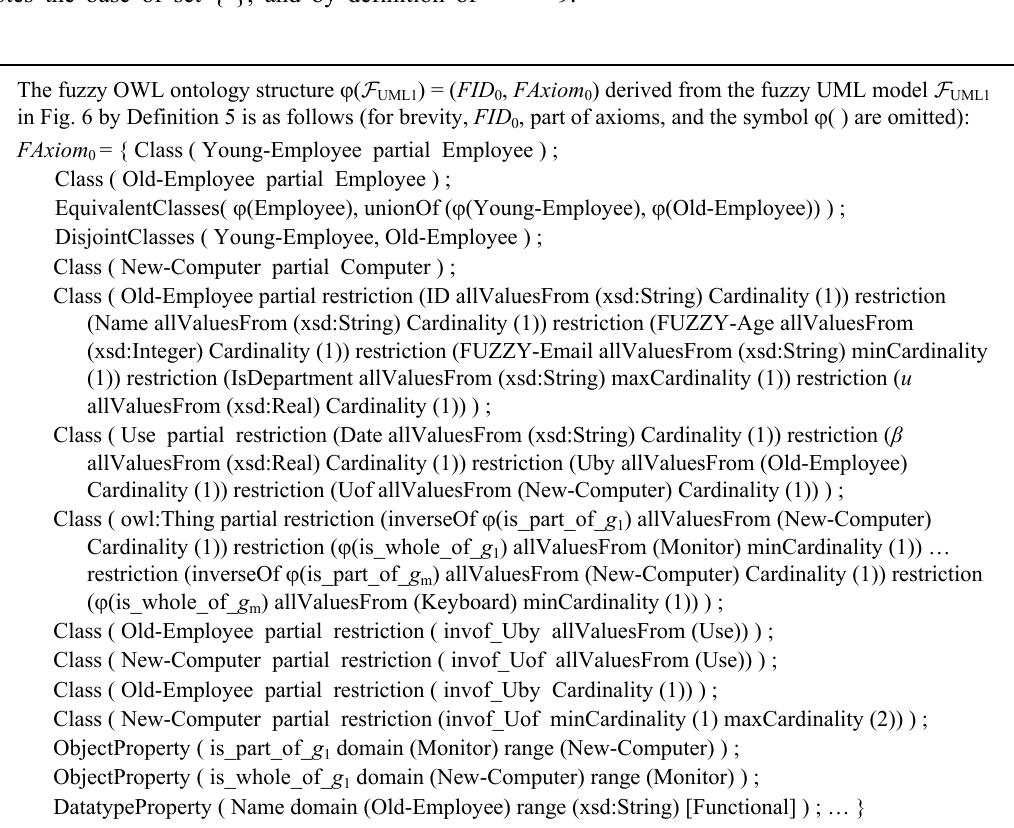
Fig. 9. The fuzzy OWL ontology structure ϕ ( F UML1 ) derived from the fuzzy UML model F UML1 in Fig. 6.